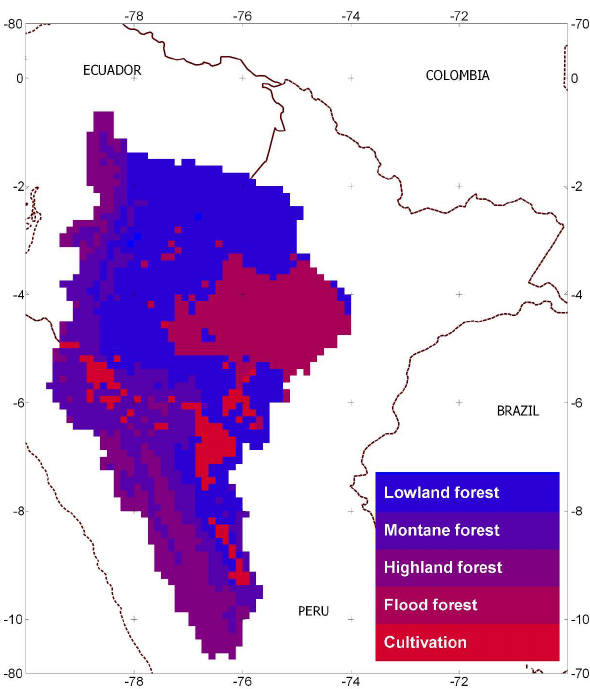
Fig. 2. The major biomes in the Mara˜n´on River basin. The classi- fication was performed using an ecosystem map and altitude and the evaluation of JULES was performed separately for each of the natural